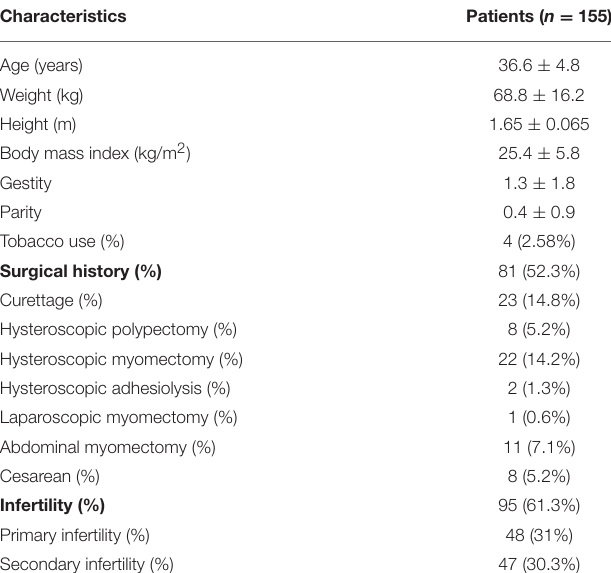
TABLE 1 | Demographic